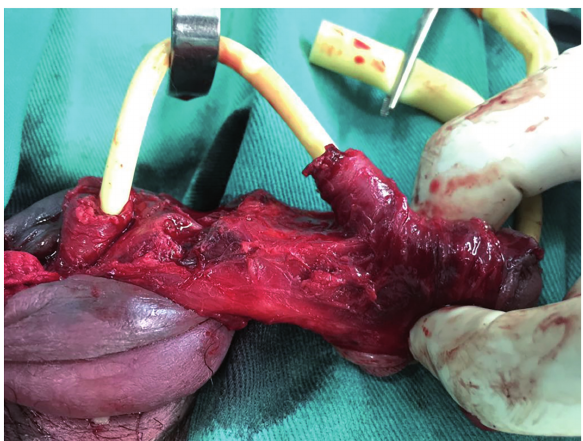
Figure 1 - Complete rupture of the urethra associated with bilateral injury in the corpus cavernosum.